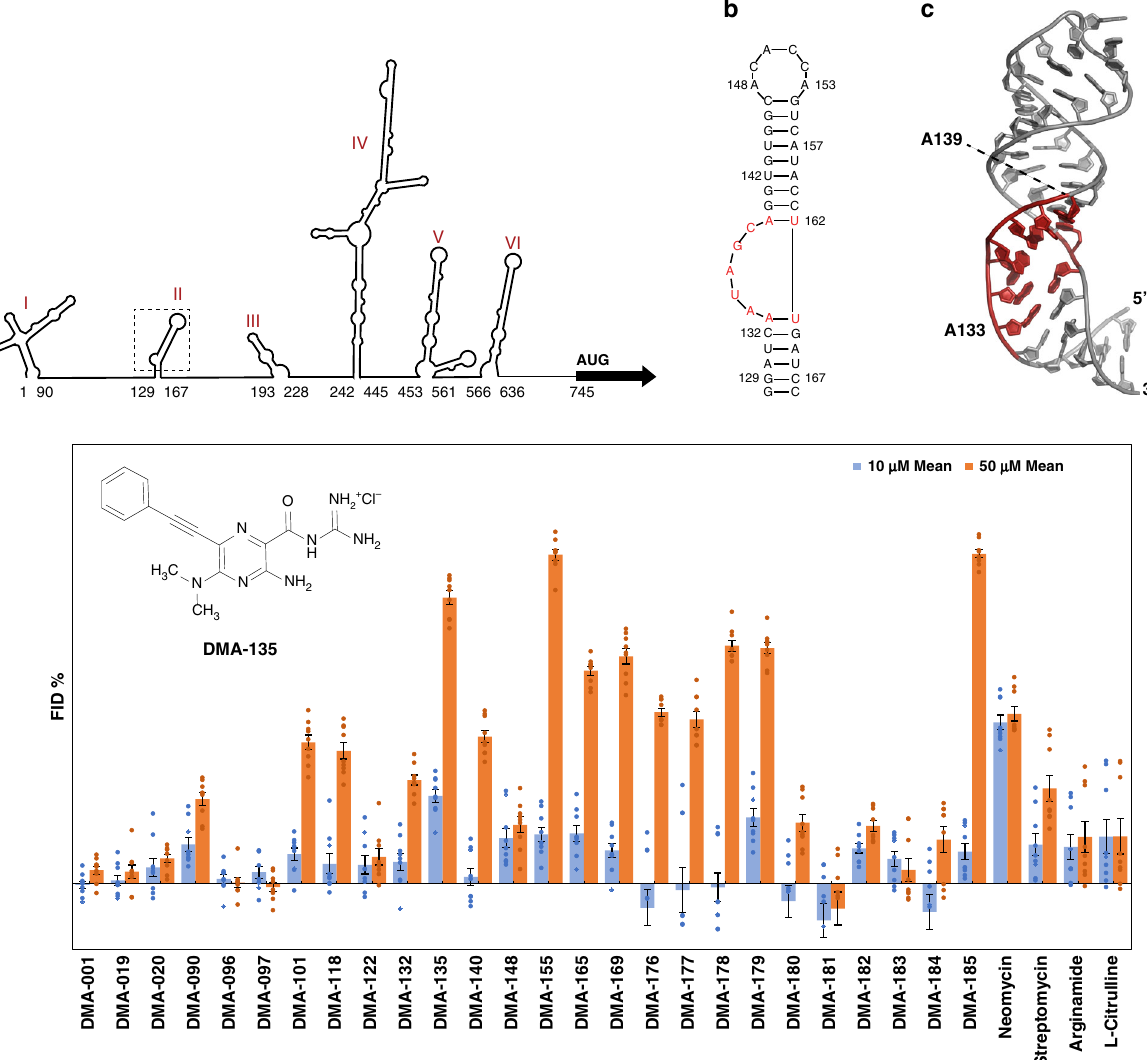
Fig. 1 RNA-biased small molecules bind to the EV71 SLII IRES domain. a Schematic of the consensus secondary structure of the EV71 5 ′ UTR determined